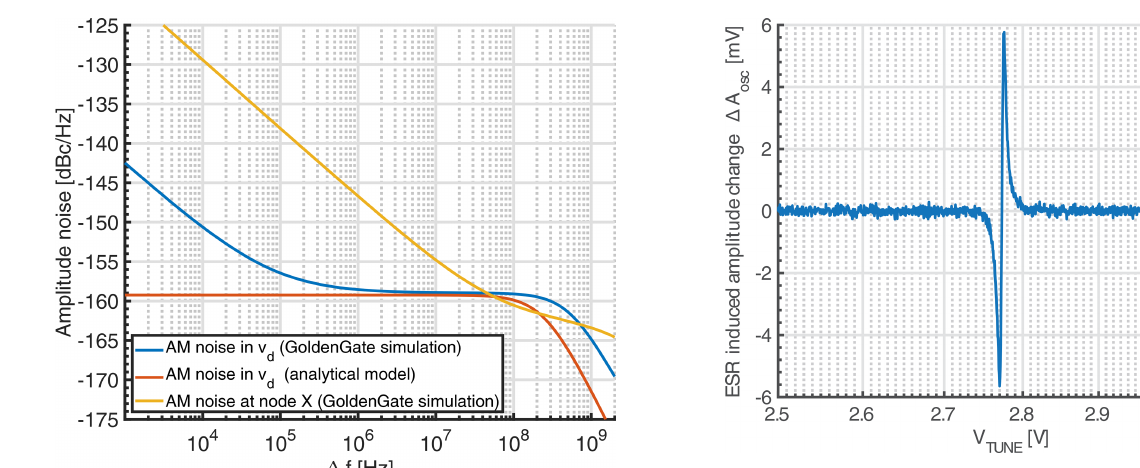
Figure 8. Comparison of the GoldenGate simulations of the ampli- tude noise in the VCO output voltage v d and the analytical model of Sect. 5 and with the simulated noise floor at the demodulated output labeled VDD osc in Fig. 2.